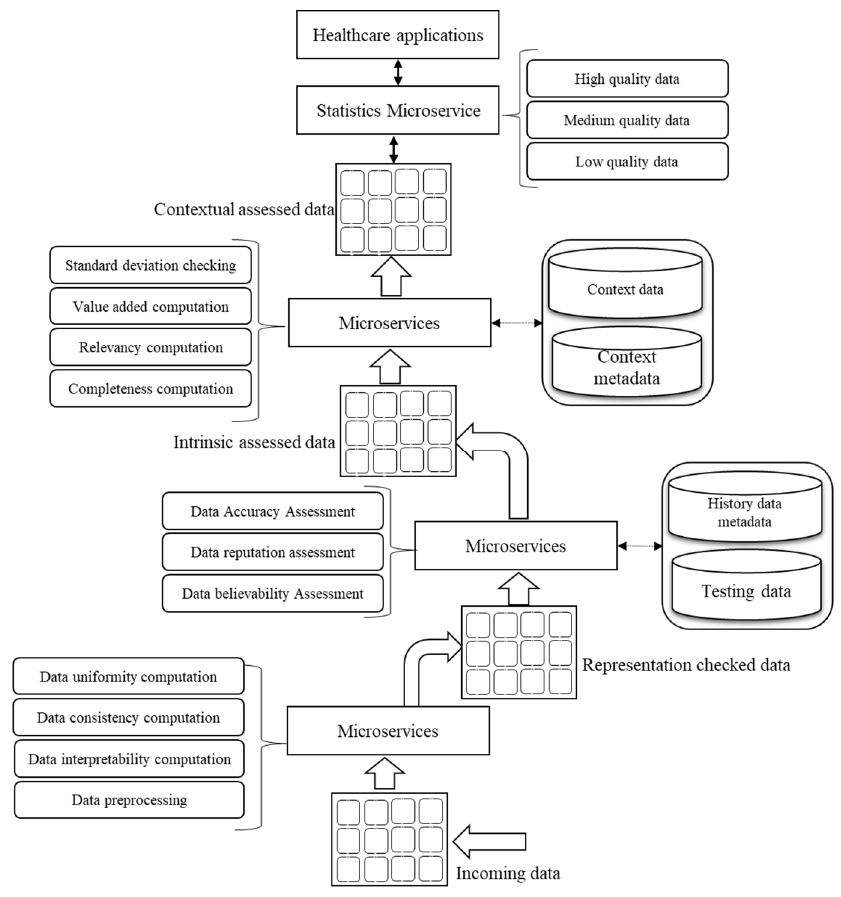
Figure 16. Appl. Sci. 2020 , 10 , x FOR PEER REVIEW